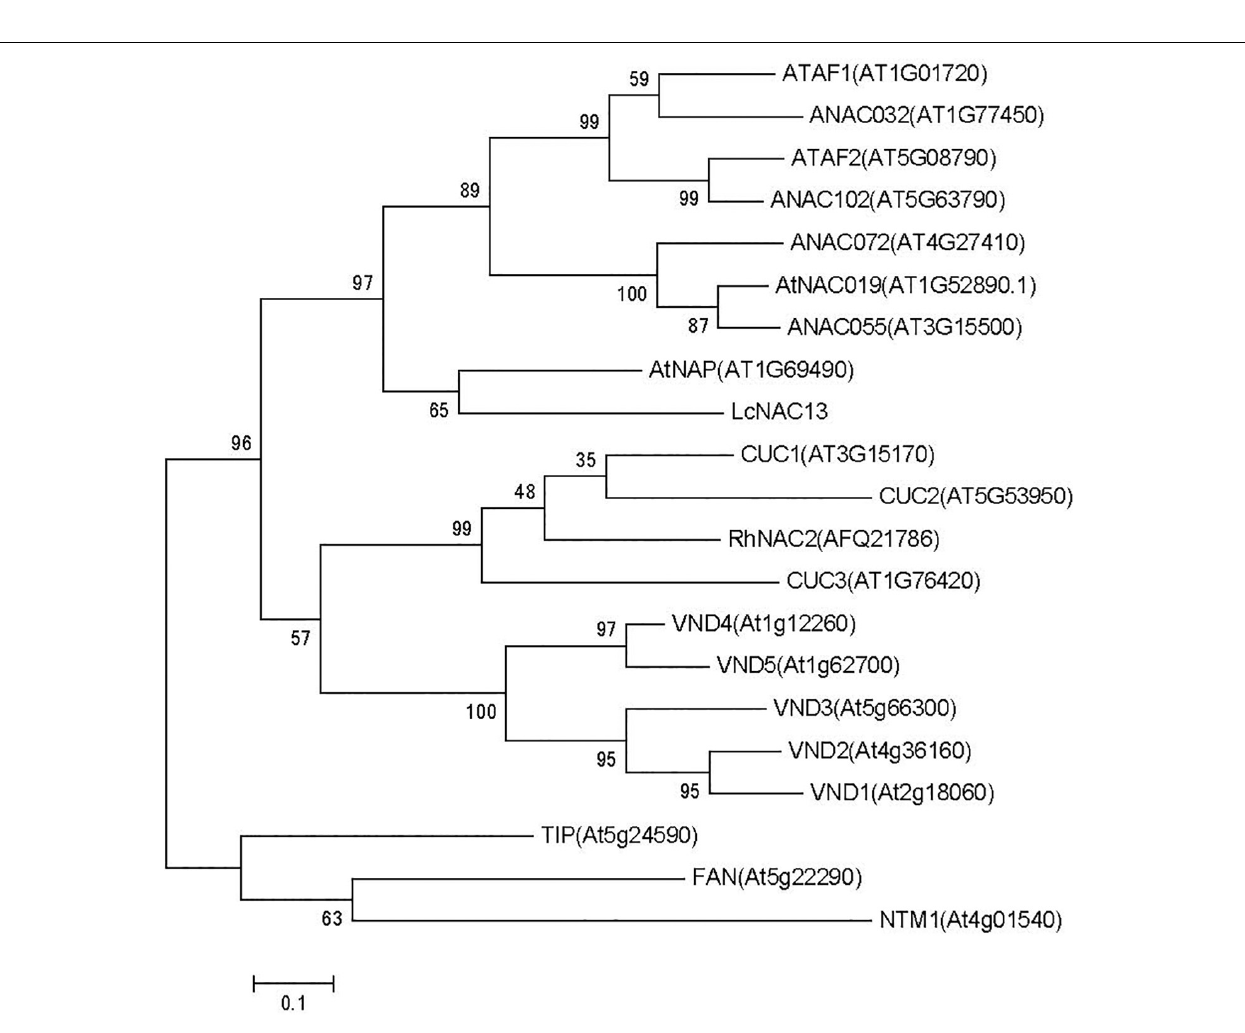
Frontiers in Plant Science |